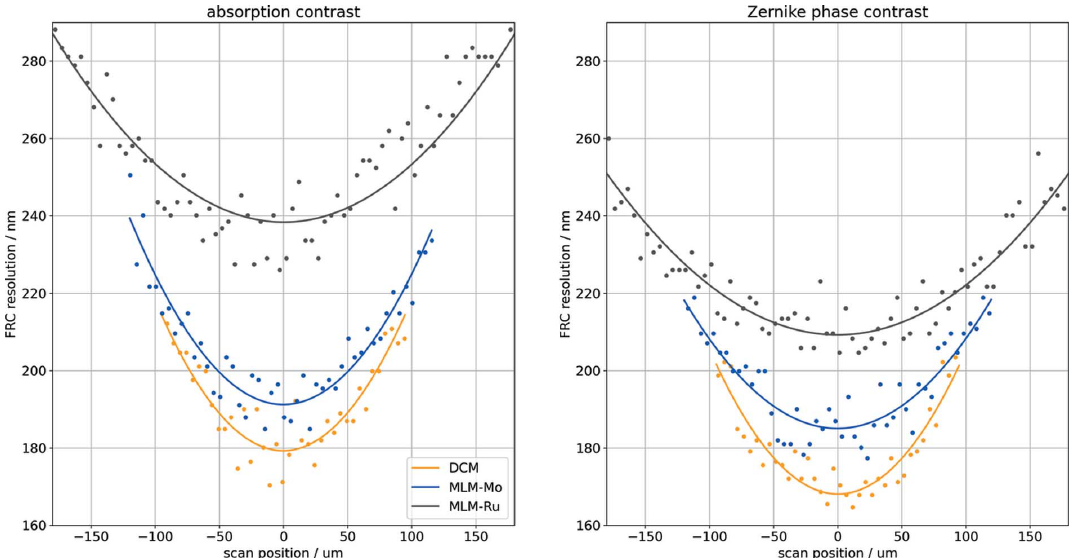
Figure 7 FRC results (1/2-bit criterion) calculated from the Siemens star test pattern for absorption contrast (left) and for negative Zernike phase contrast (right). The FRC shows that the resolution deteriorates with increasing energy bandwidth, as expected.